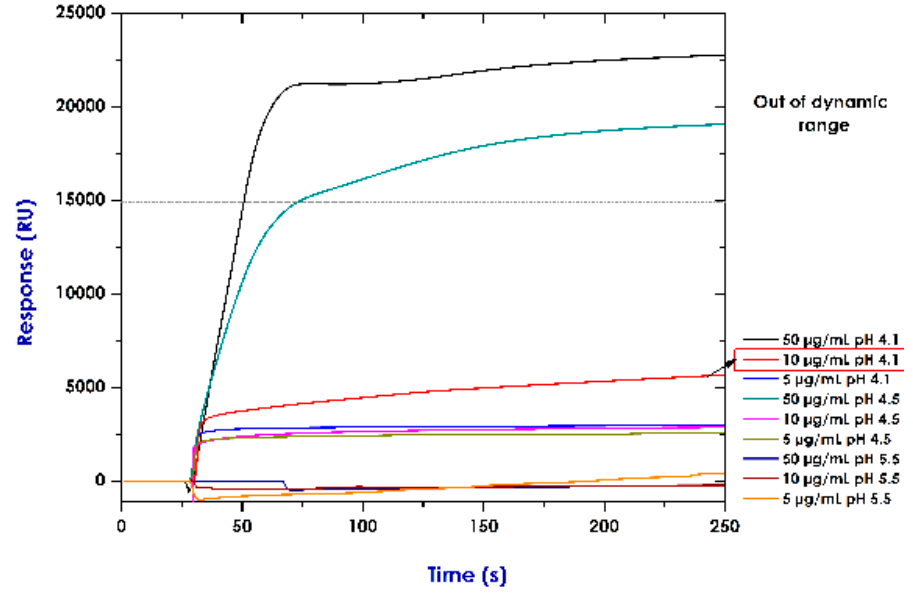
Figure 2. The pH scouting of human recombinant TNF- α (17 KDa molecular mass and 5.8 pI). The protein was diluted in 10 mM sodium acetate buffer, pH ranging from 4.1 to 5.5. Ligand surface concentration on the chip at pH 4.1 was much higher than that obtained at pH 5.5. Optimum pre-immobilisation pH was 4.1 (10 µg/mL).